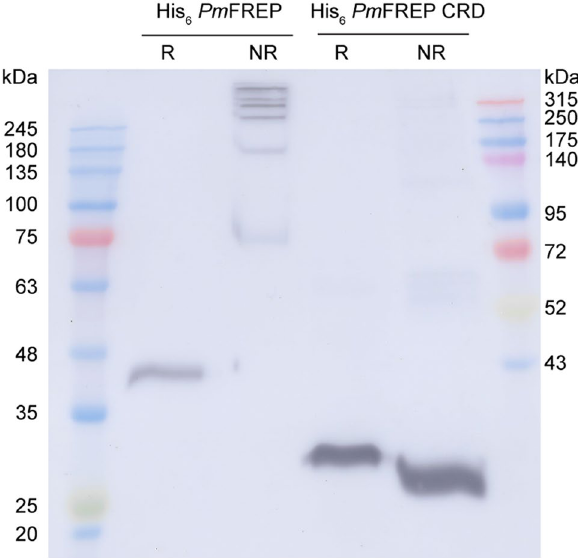
Figure 2. Western blot of His 6 Pm FREP and His6 Pm FREP CRD under reducing (R) and non-reducing (NR) conditions. Anti-His 6 antibody was used as the primary